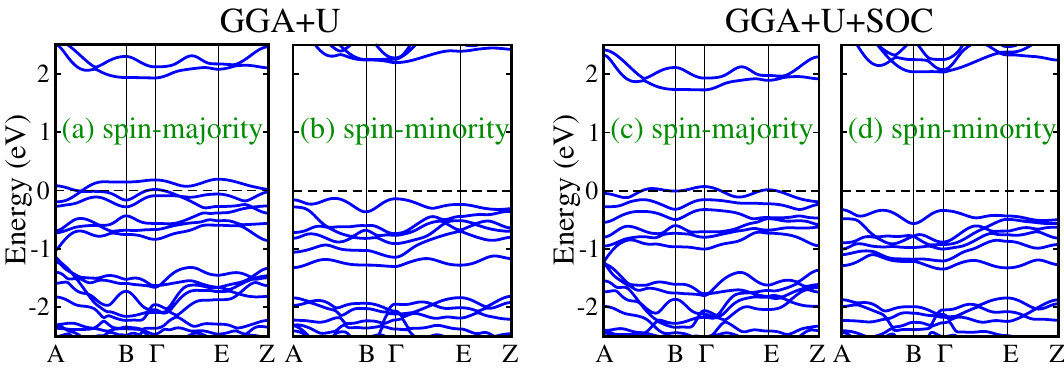
Figure 6. Calculated spin-polarized ( a / c ) spin-majority and ( b / d ) spin-minority band structures within GGA + U / GGA + U + SOC method in Cr-doped Lu 2 NiIrO 6 ( Lu 2 Ni 0.5 Cr 0.5 IrO 6 ) double perovskite